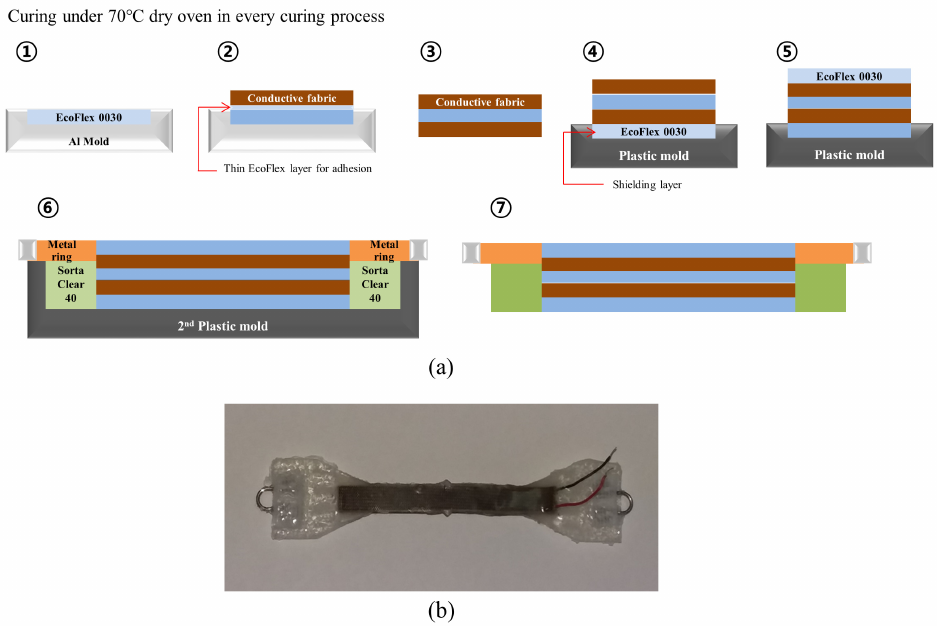
Figure 3. ( a ) Sensor fabrication process. Curing was performed at 70 °C for 10 min in drying oven in every curing process. ( b ) Fabricated sensor.